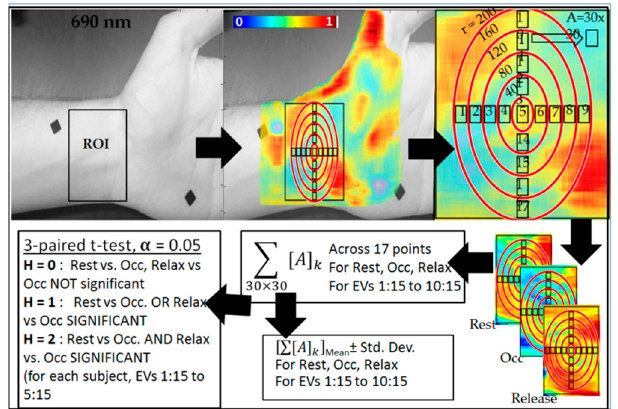
Figure 5. Flowchart of the steps in quantitative analysis of diffuse reflectance data using various eigen values (EVs) to determine significant difference (if any) across the time stamps (rest, occlusion, and relax).